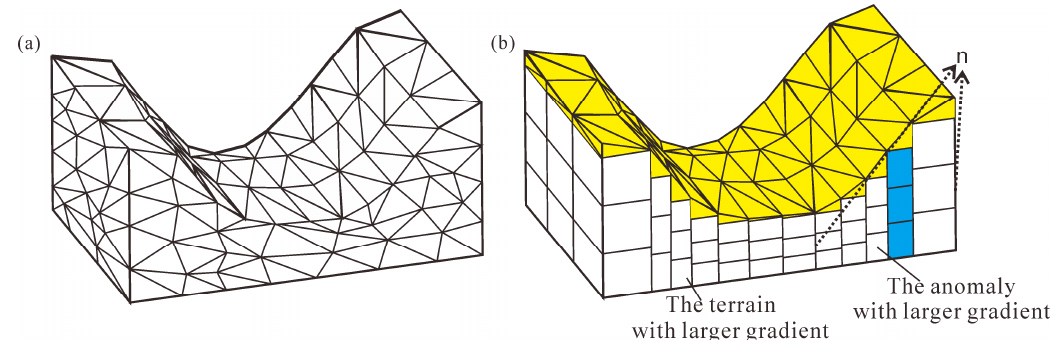
Figure 2. Mesh with triangulation and equivalent dimension in undulating terrain. ( a )Triangulation; ( b ) equivalent dimension.